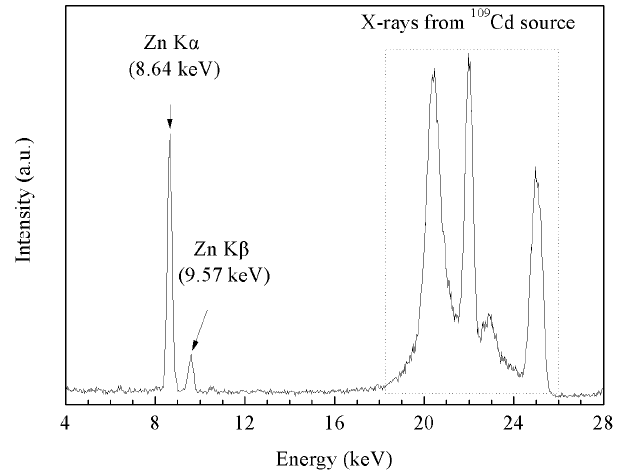
Figure 5. A typical XRF spectrum acquired from sample 2 , showing the characteristic Zn K α and Zn K β X-ray peaks.